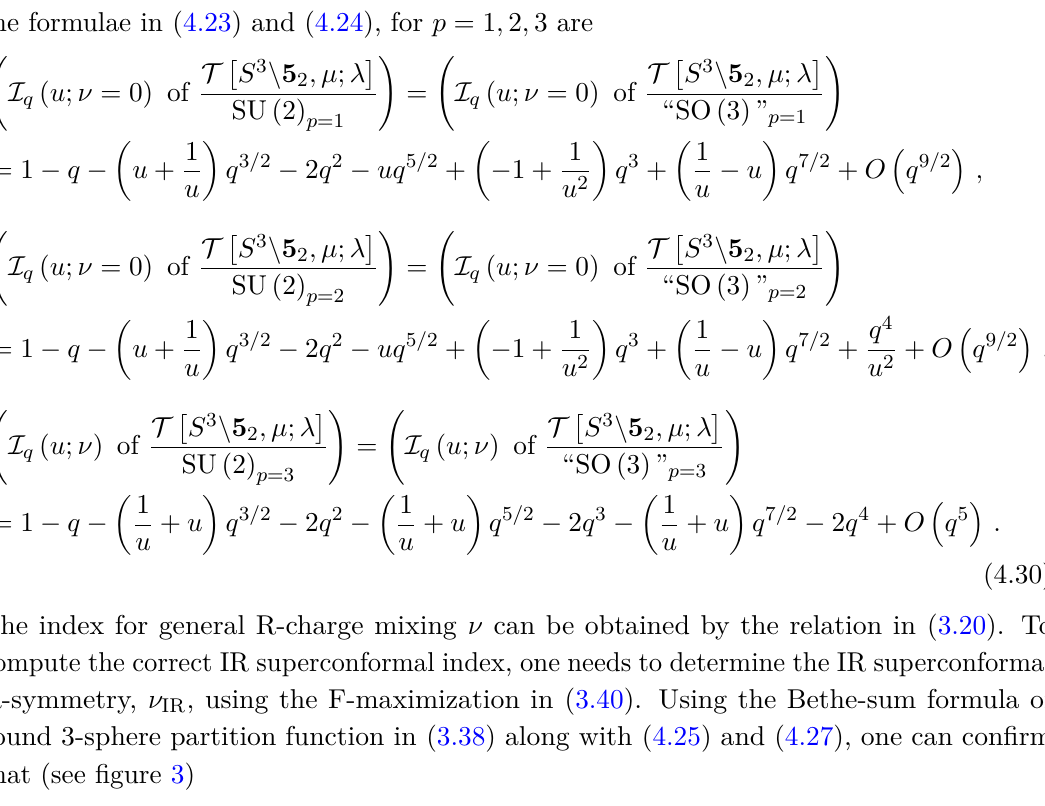
Figure 3 . |Z (5 2 ) p located at ν = 0 and its values are SUSY enhancement when p = 1 , 2 , 3